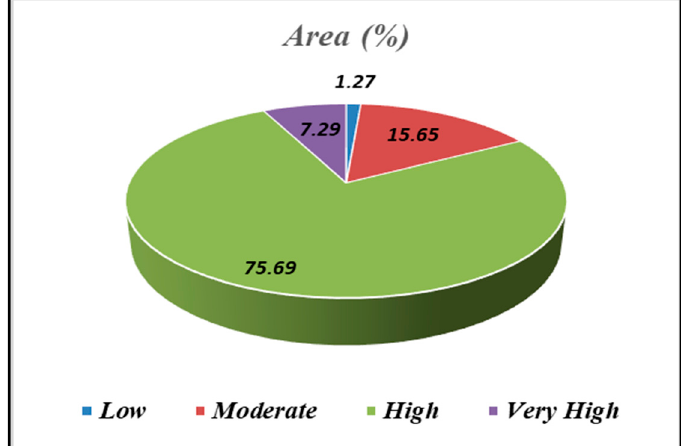
Figure 14. Groundwater potential zone map of the study area.